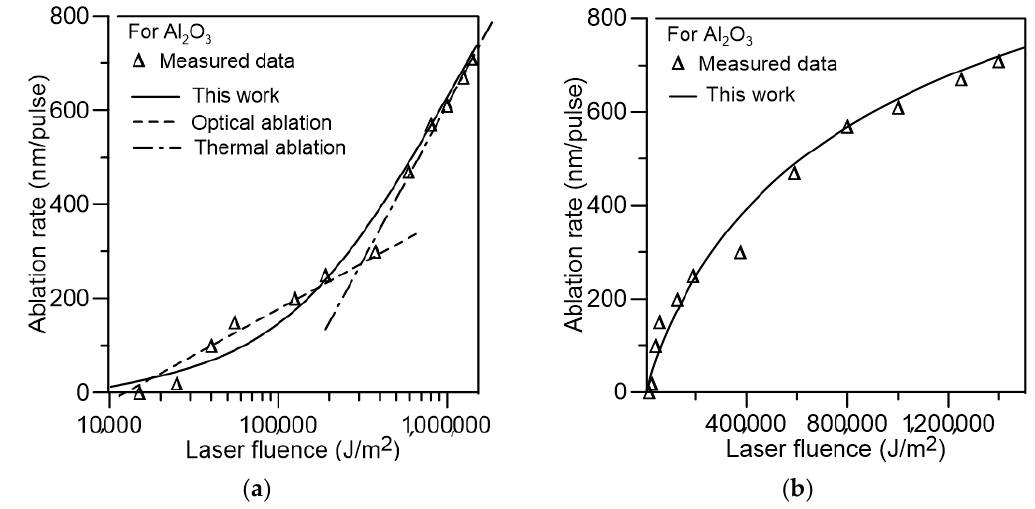
Figure 3. Ablation rate versus laser fluence of Al 2 O 3 ceramics for the solid line predicted by this work and the triangle symbols measured by the published paper [29] ( a ) with the horizontal axis of the logarithm scale, and ( b ) with the horizontal axis of the linear scale.